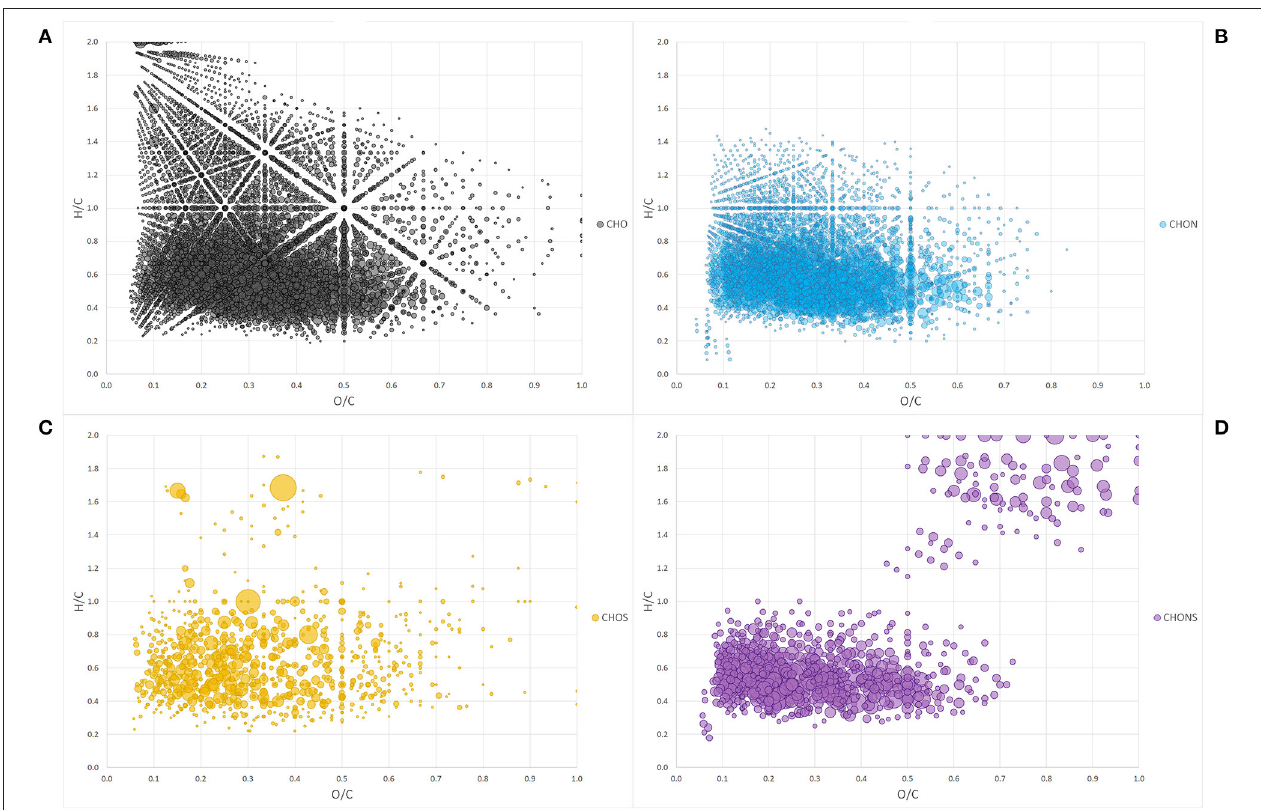
FIGURE 1 | Van Krevelen diagram of heteroatom class groups: CHO (A) , CHON (B) , CHOS (C) , CHONS (D) . Each bubble is a molecule assigned and the size of the bubbles is a measure of their relative